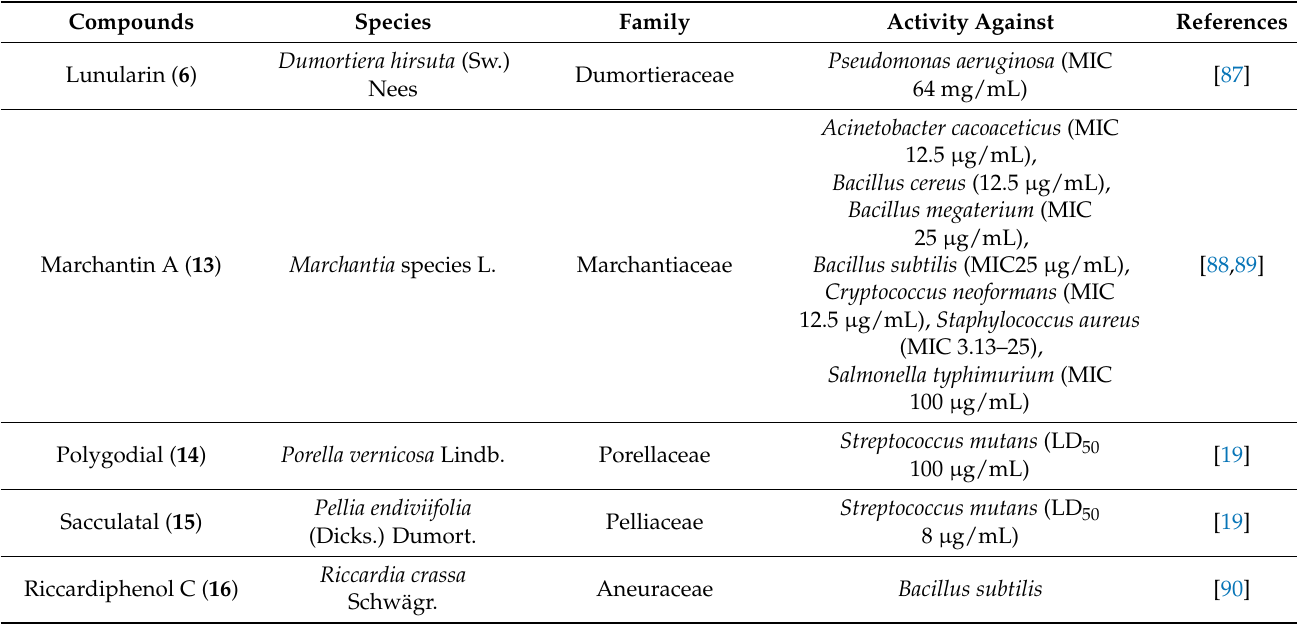
Table 4. Antimicrobial activities of compounds isolated from bryophytes.